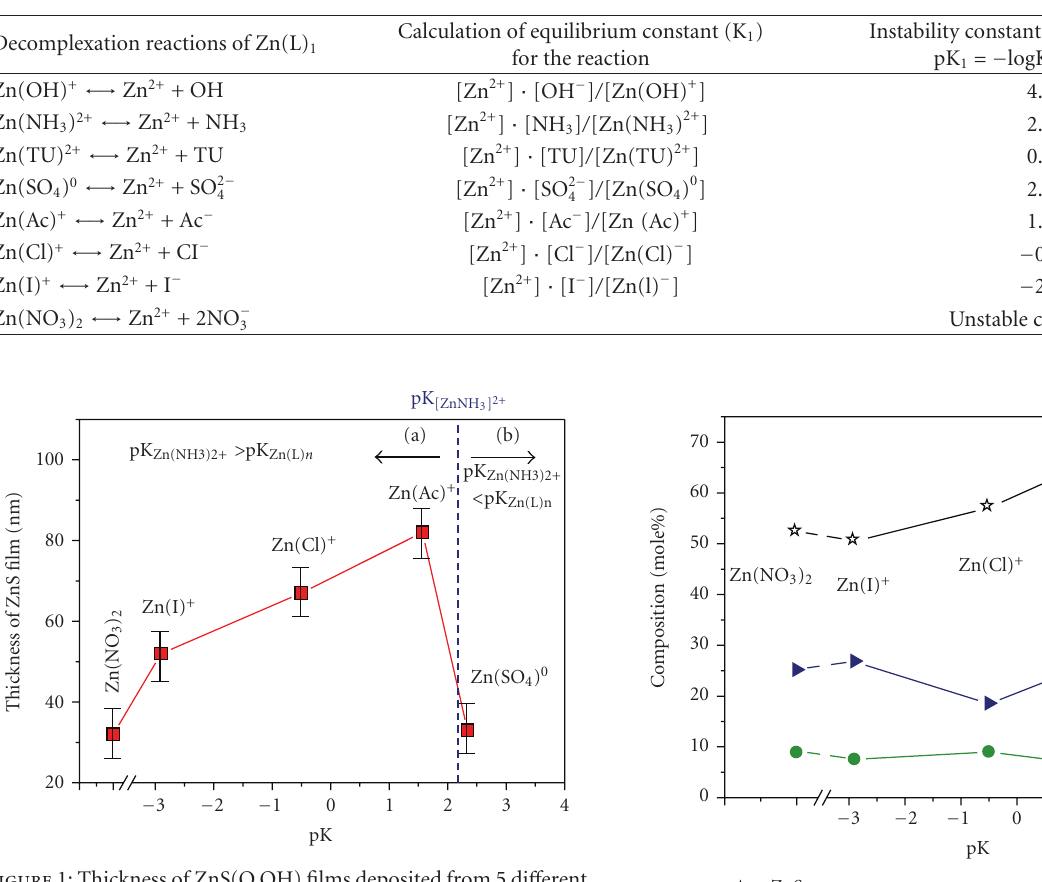
Table 1: Instability constants pK of Zn complexes [15].